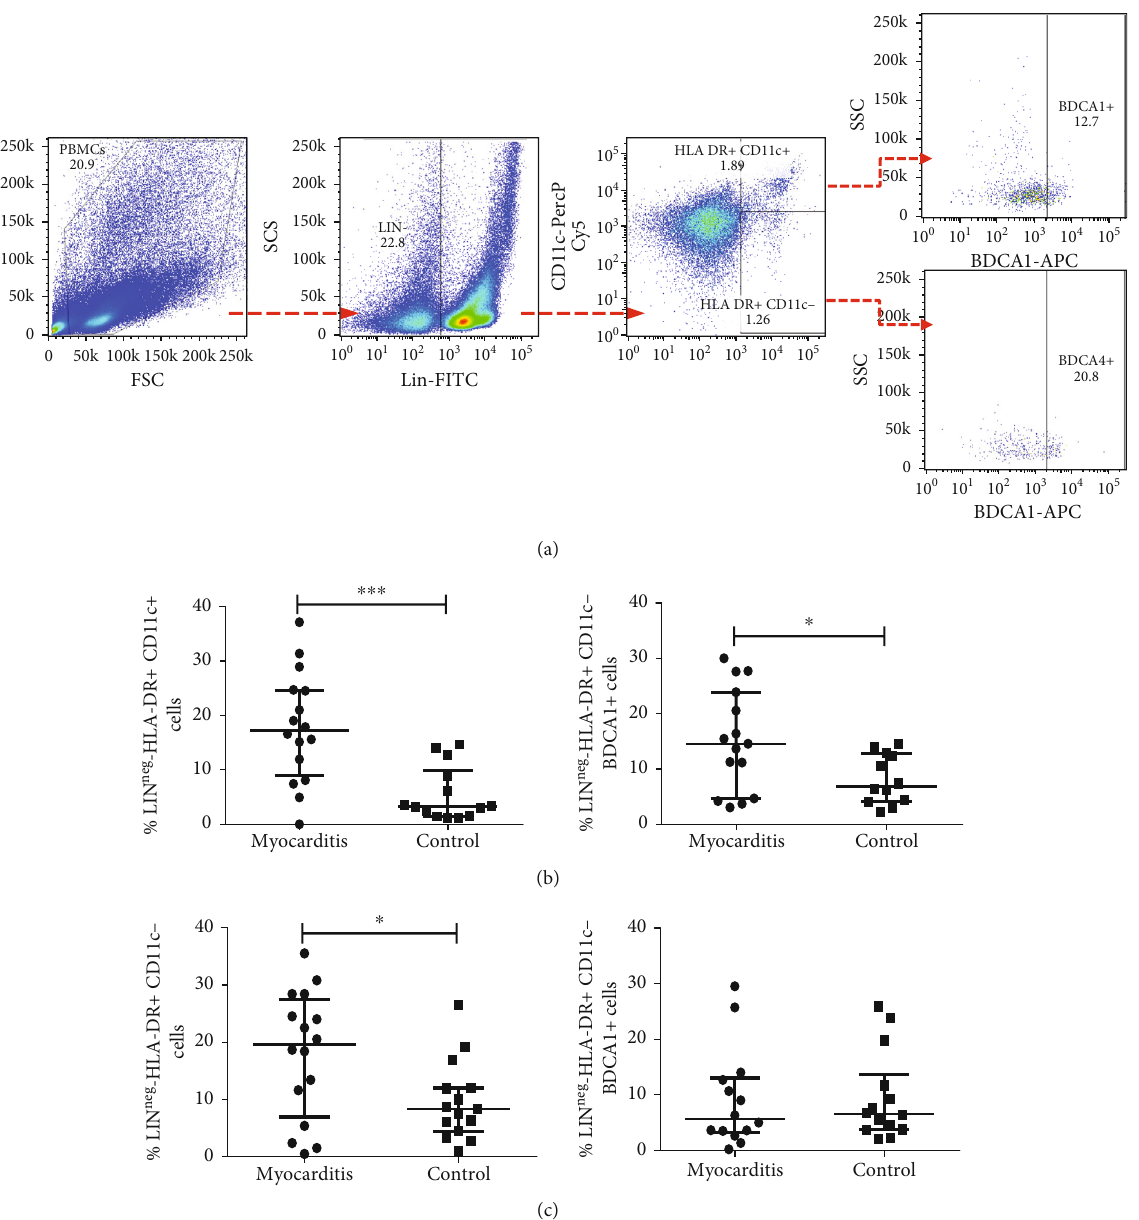
Figure 1: Percentages of plasmacytoid dendritic cells and myeloid dendritic cells from myocarditis patients and controls. PBMC from myocarditis and control subjects were immunostained and analyzed by fi ve-color fl ow cytometry. (a) Gating tree from negative lineage marker (LINneg), HLADR + CD11c + , and BDCA1+ (myeloid dendritic cells-mDCs), and from HLADR + CD11c − and BDCA4+ (plasmacytoid dendritic cells-pDCs). (b) Percentage of myeloid DCs ( LINnegHLA − DR + CD11c + ) and BDCA1+ from myocarditis and healthy volunteers. (c) Percentage of plasmacytoid DCs ( LINnegHLA − DR + CD11c − ) and BDCA4+ from myocarditis patients and controls. ∗ p < 0 : 05 , ∗∗ p < 0 : 0